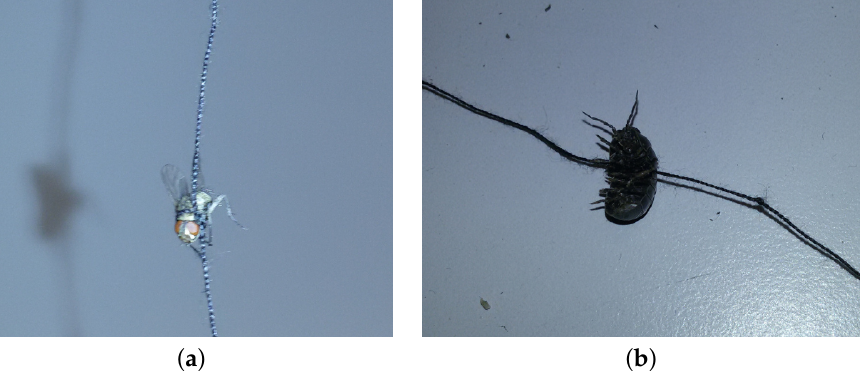
Figure A7. ( a ) Musca domestica (a small house fly), ( b ) Armadillidium vulgare (a small woodlouse;